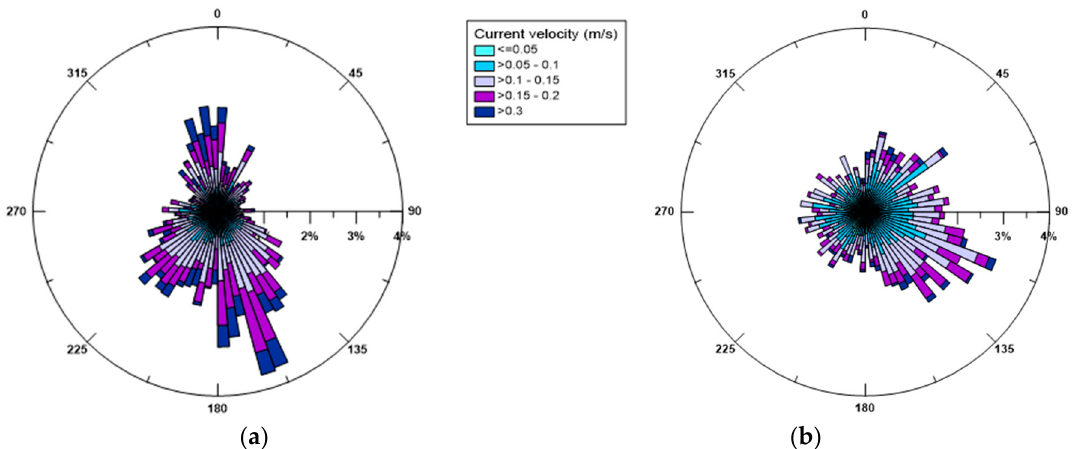
Figure 5. Seasonal currents (in m/s) near the sea surface in 2015 ( a ) winter and ( b ) summer. Direction of current propagation is shown.